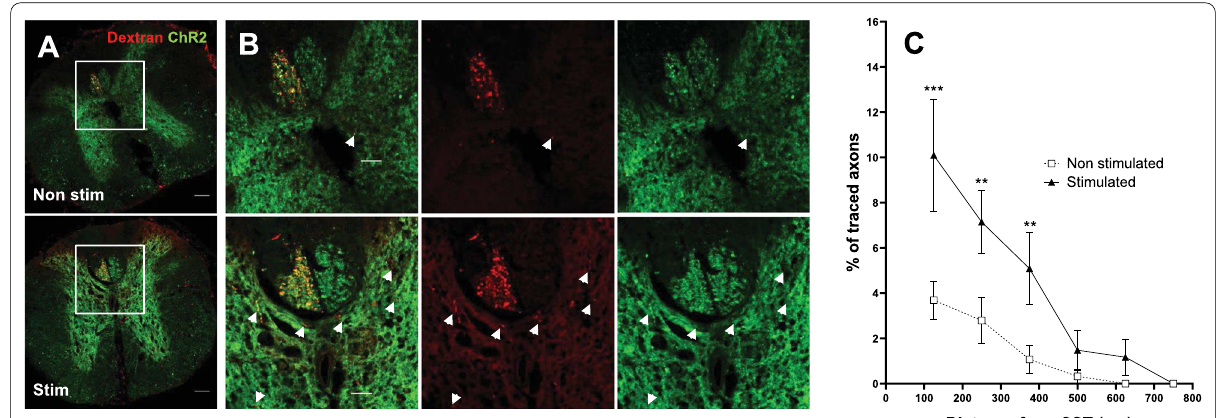
Fig. 6 Neuronal stimulation induces axonal sprouting before the lesion. A Representative images of traced (Dextran‑Alexa594) CST and ChR2‑YFP in stimulated and non‑stimulated Thy1‑ChR2 mice in spinal cord sections 500 μm rostral to the lesion core. Scale bar: 100 μm. B Close‑up higher magnification images from indicated regions on A . White arrows indicate double‑positive Dextran‑Alexa 594/ChR2‑YFP sprouted axons. Scale bar: 50 μm. C The number of double‑positive Dextran‑Alexa 594/ChR2‑YFP sprouted axons in the grey matter as a normalized ratio of Dextran‑Alexa 594‑traced CST axons shows a significantly higher percentage of sprouted axons in stimulated animals at distances up to 400 µm laterally and ventrally from CST. Data are expressed as mean s.e.m. at each distance from the CST (n 4 mice) ***p < 0.001; **p < 0.01 denote significant ± = differences in ANOVA followed by Bonferroni